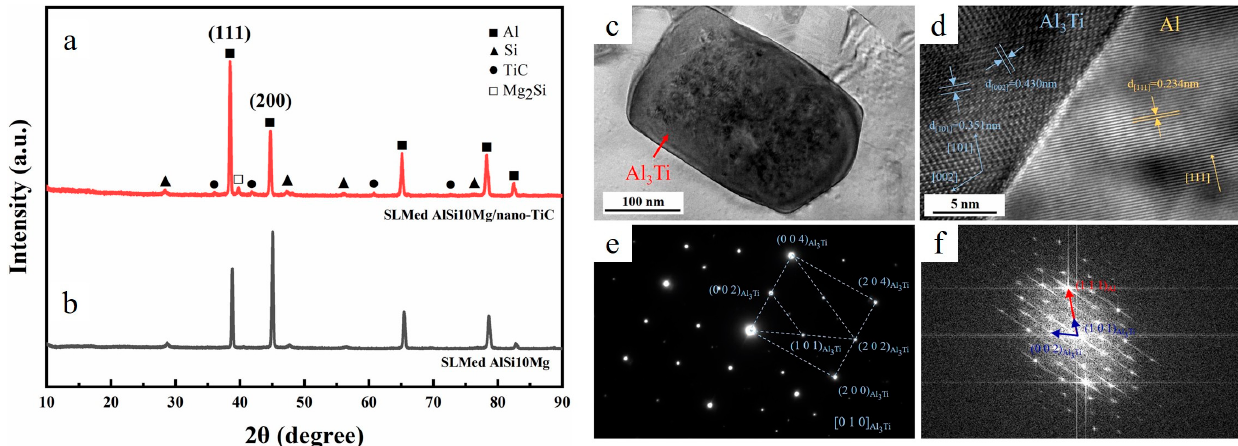
Figure 10. Diffractograms of the LPBFed AlSi10Mg ( a ) and AlSi10Mg/5 wt.%TiC ( b ) specimens, HRTEM image of the D0 22 –Al 3 Ti/Al matrix ( c ) and interface ( d ), SAED patterns taken at the D0 22 -Al 3 Ti along (010) Al 3 Ti ( e ), FFT patterns of the D0 22 –Al 3 Ti/Al matrix interface ( f ) (SAED stands for selected area electron diffraction and FFT for fast Fourier transform, (reproduced with permission from [31]).